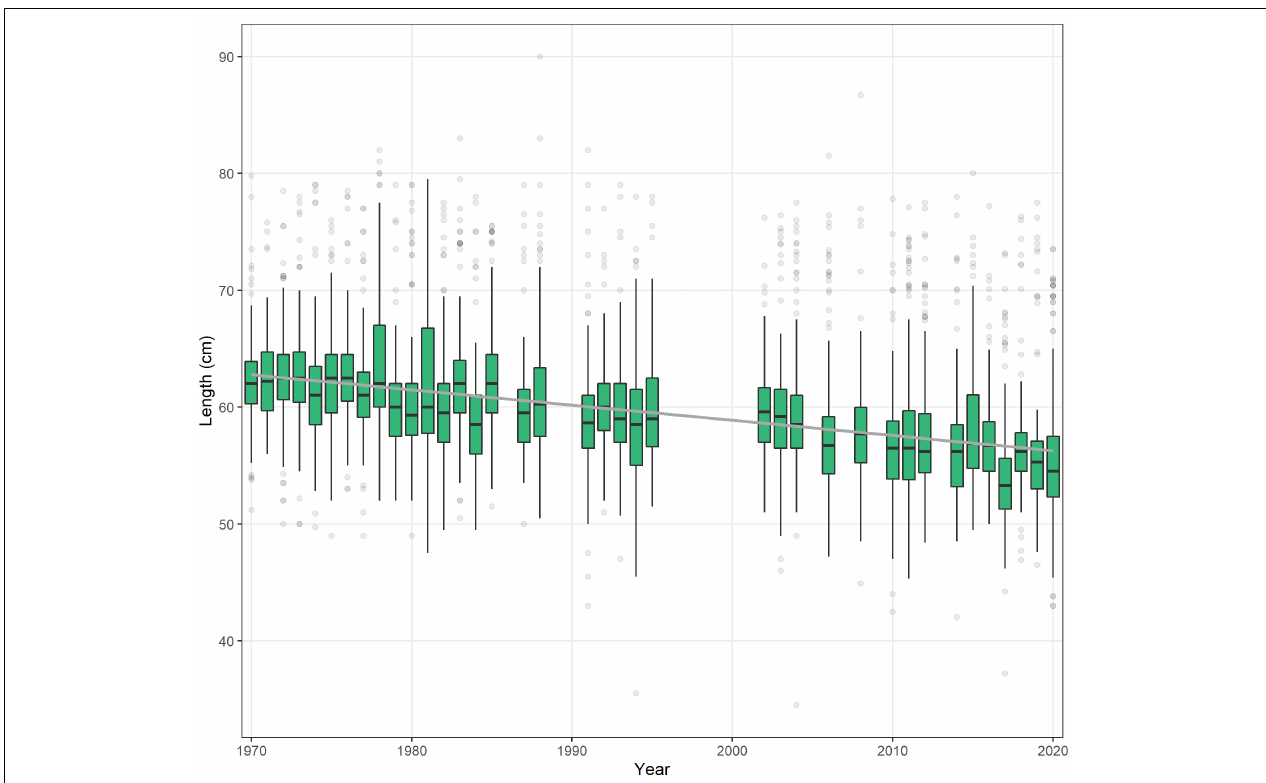
FIGURE 5 | Length of wild female kelts per year measured in the Burrishoole traps between 1970 and 2020. Gray line indicates the linear relationship between year and length of